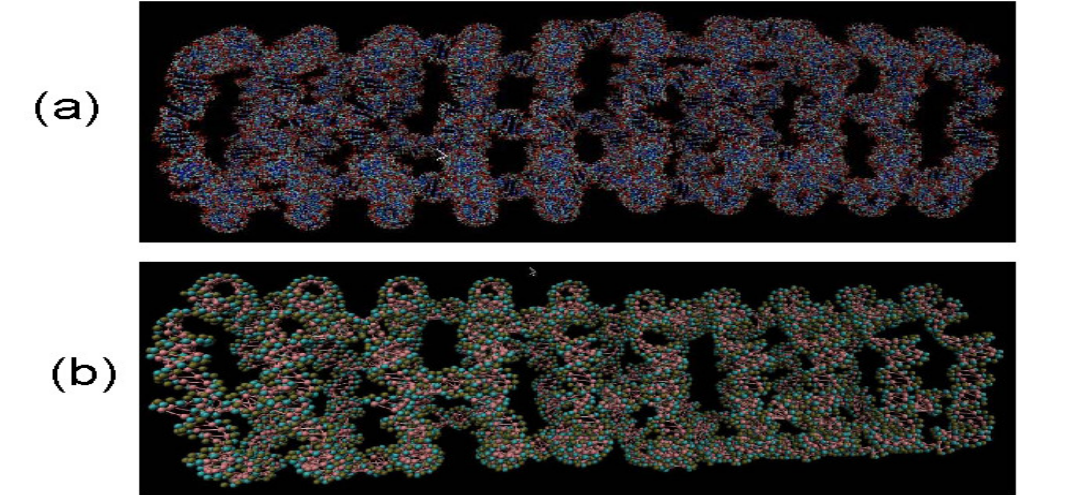
Figure 1. RNA nanotube made from 10 nanorings for all-atom Visual Molecular Dynamics (VMD) simulations in ( a ) and for coarse-grained VMD simulations under 3 bead approximations in ( b ). Evidently, in coarse-grained model in ( b ), the number of atoms are significantly reduced, which facilitates the calculations for analysing physical properties of RNA nanotubes.